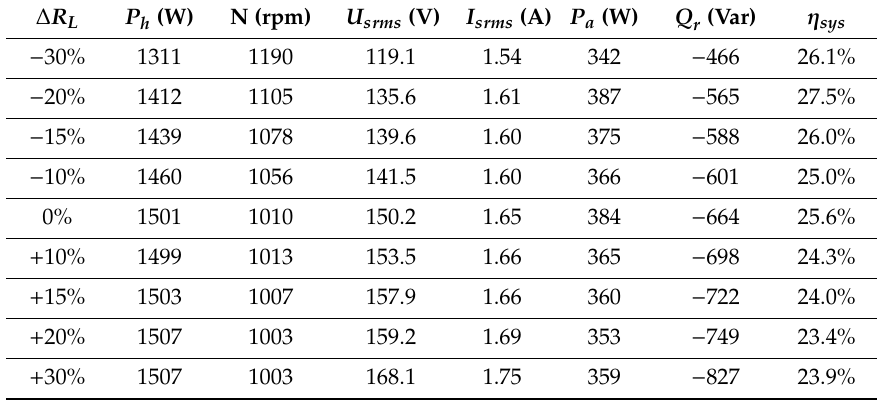
Table 8. Steady-state hydraulic and electromechanical parameters after a sudden change in the resistance value. ∆ R